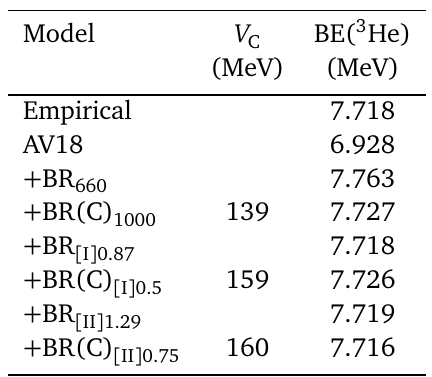
Table 1: Empirical and calculated values of the 3 He binding energy and strength parameter V of the additional C-3NP, Eq. (4), for models used in this paper. See the C text for the description of the